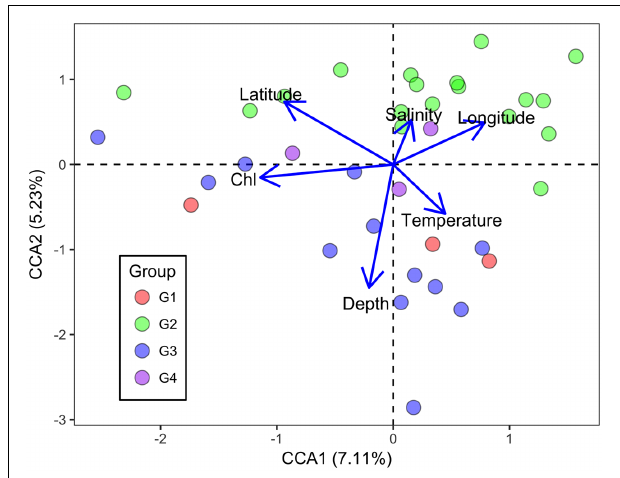
FIGURE 5 | Canonical correspondence analysis of all genes detected with environmental parameters in the ECS. Blue and purple symbols denote bottom samples, while orange and green symbols denote surface samples. Sal denotes salinity, Temp denotes temperature, and Chl denotes chlorophyll a